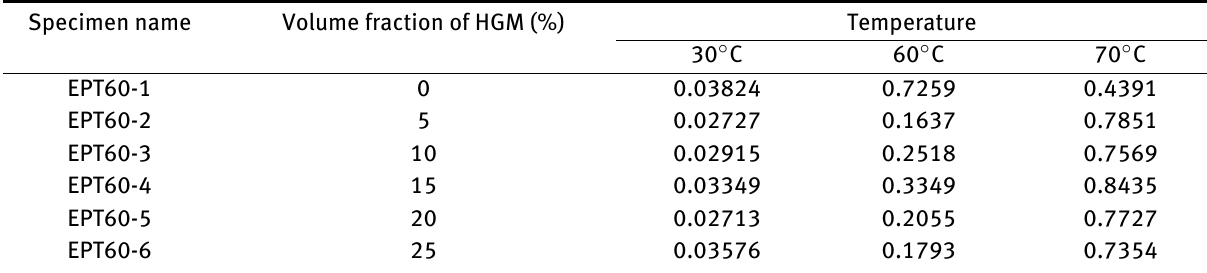
Table 6: Comparison of tan δ values of HGMSF and neat epoxy resin at different temperature